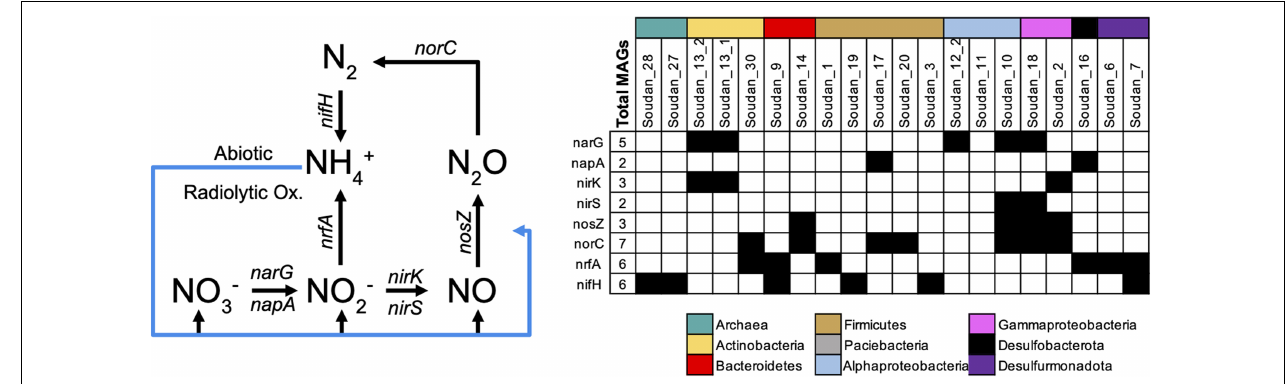
FIGURE 6 | Nitrogen cycling genes detected in metagenome assembled genomes (MAGs). Nitrogen biogeochemical cycling pathways (left) interpreted from genes detected in Soudan MAGs (Right). Blue lines represent abiotic